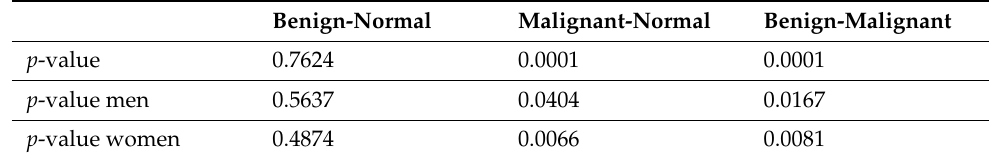
Table 3. p -values calculated for the Mann-Whitney statistical test to compare groups of subjects.